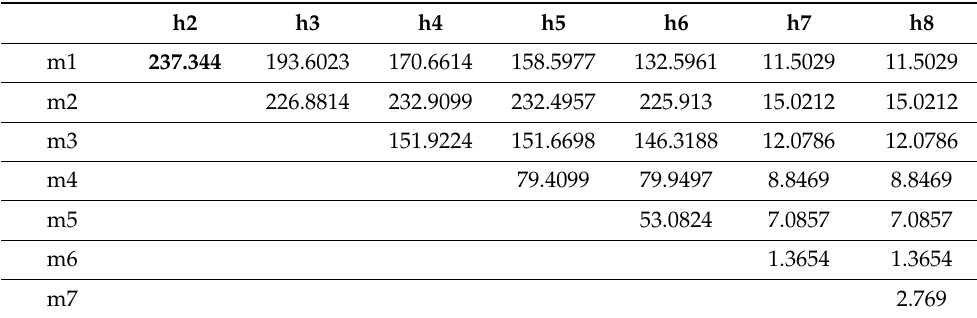
Table 13. Log-rank statistics for matching the C 2 HEST risk strata for all causes mortality in non- CAD cohort.